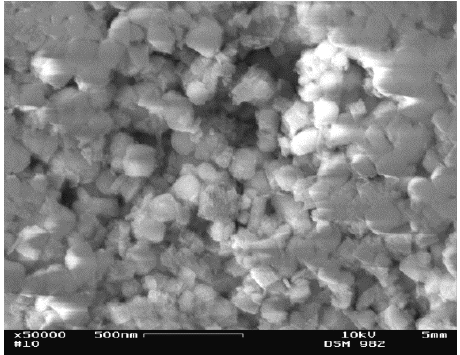
2 at 50,000× magnification.